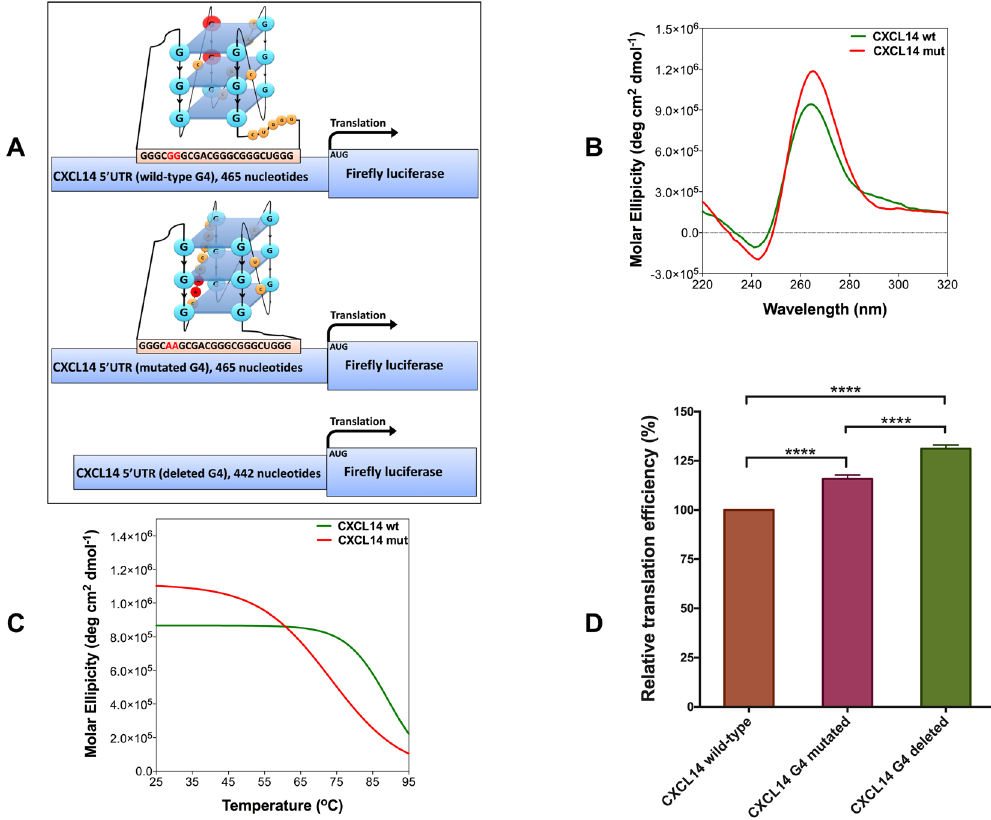
Figure 5. Two adjacent mutations in the 5 ′ UTR of CXCL14 destabilise the RNA G4 and affect its regulatory function. ( A ) Schematic representation of three different mRNAs of firefly luciferase reporter constructs. Wild- type construct contains full-length 5 ′ UTR of CXCL14 . In the G4-mutated construct, two guanines are replaced by two adenines. To make the G4-deleted construct, 23 nucleotides that predicted to form the RNA G4 were deleted. Schematic drawing of wild-type and mutated G4s are proposed based on RNAfold and QGRS-mapper predictions and in vitro results. ( B ) CD spectra of CXCL14 wild-type and mutated RNA G4 oligos in KCl. ( C ) CD melting curves of CXCL14 wild-type and mutated RNA G4 oligos at 260 nm. ( D ) Relative in vitro translation efficiency of the wild-type, G4-mutated and G4-deleted constructs as judged by measuring firefly luciferase enzymatic activity. Data were analysed using one-way-ANOVA (n ≥ 3, error bars represent the SEM, asterisks ( * ) indicate significance calculated by the Tukey multiple comparisons